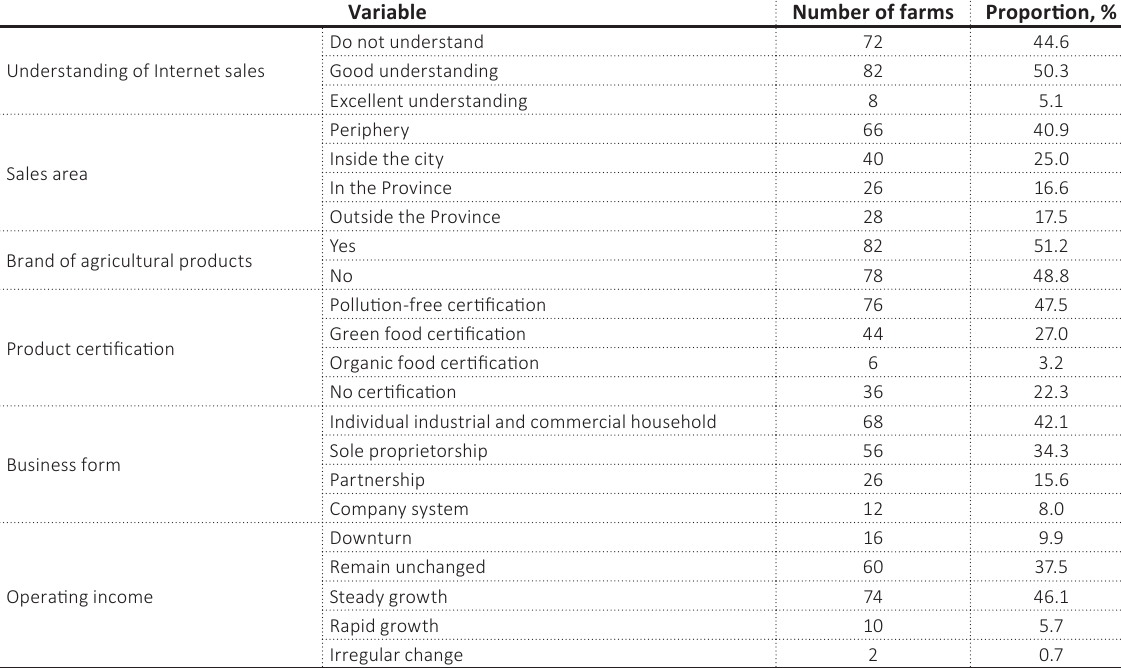
Table 2 (cont.). Statistical analysis of